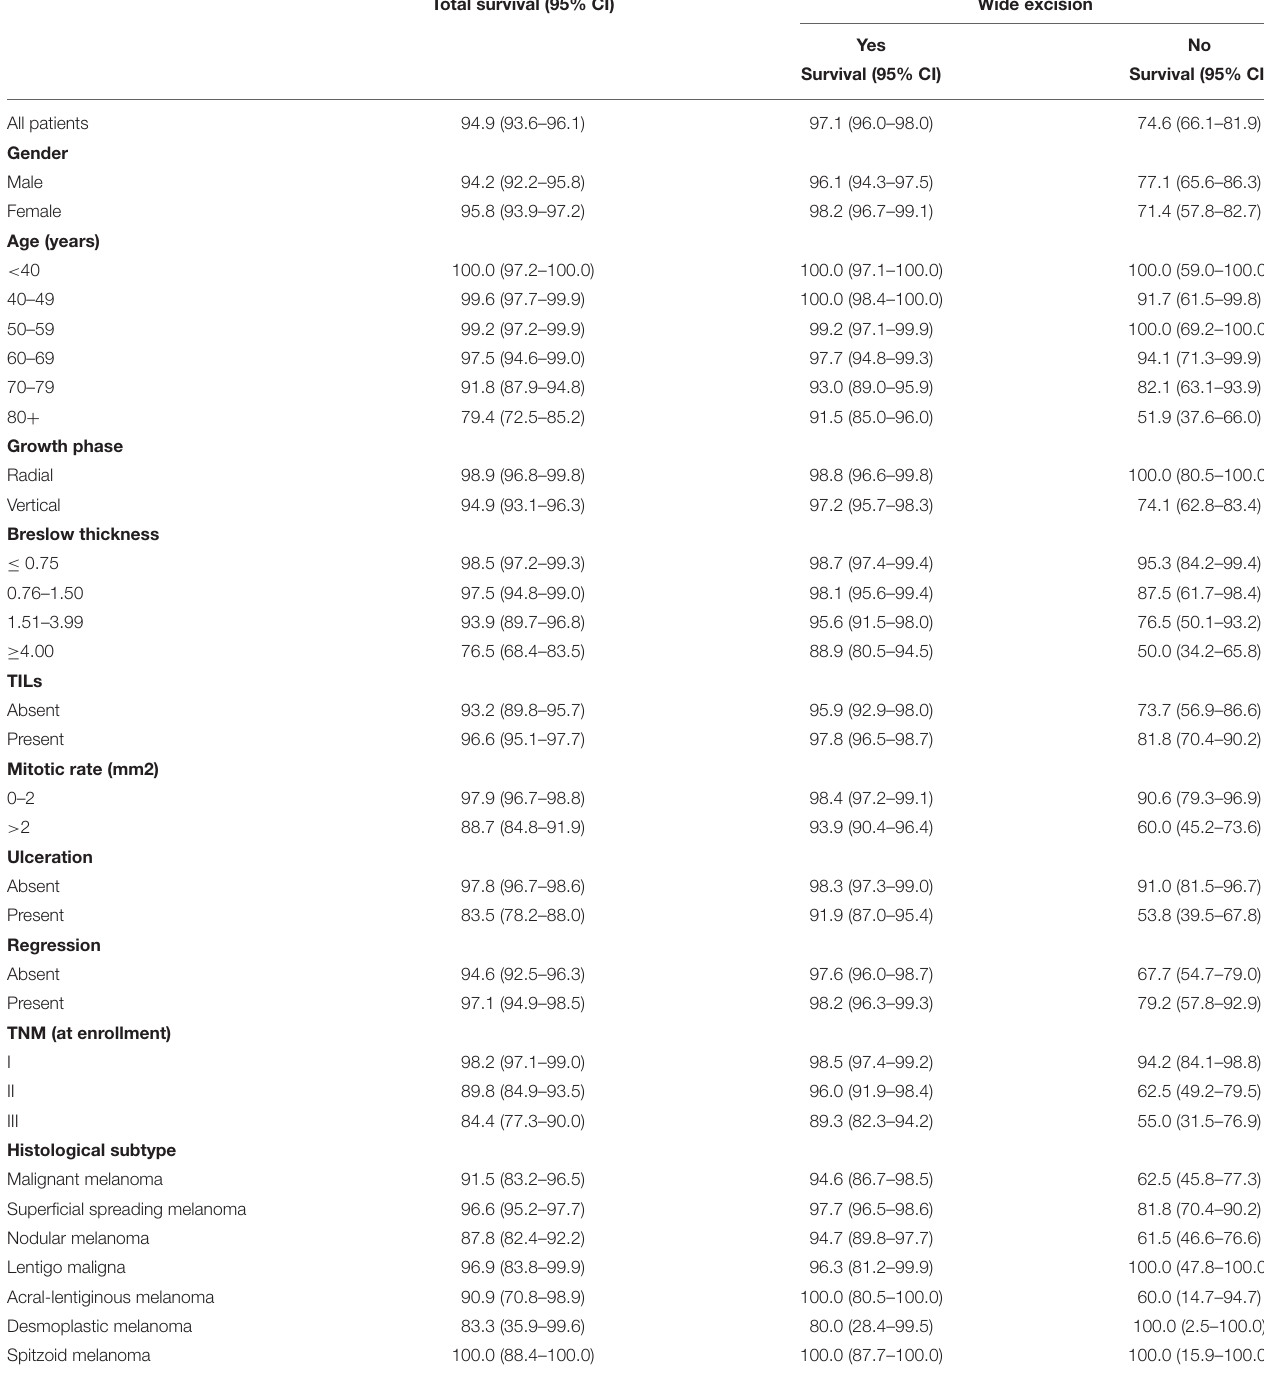
TABLE 2 | Bivariate analyses of 2-year survival (Kaplan Meier analysis) by clinical-histological characteristics and wide excision